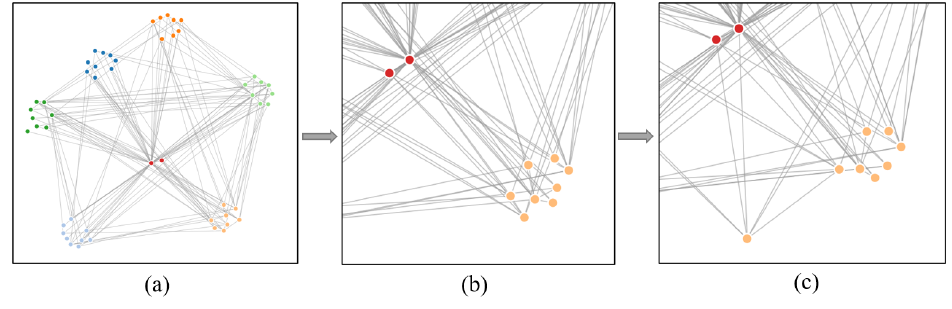
Figure 3. Illustration of User detail exploration. ( a ) global view; ( b ) local view; ( c ) local view after